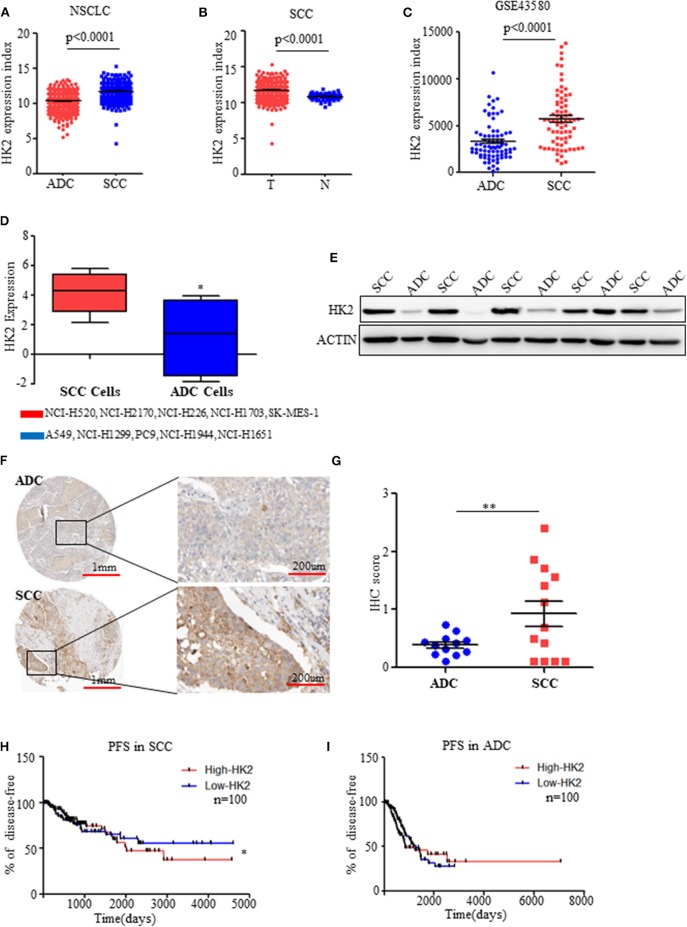
HK2 is highly expressed in SCC compared to ADC. (A) HK2 expression index in NSCLC samples from TCGA database. (B) HK2 expression index in SCC tumor samples compared with that in normal tissues from TCGA database. (C) HK2 expression index in NSCLC from the GSE43580 cohort. (D) HK2 expression in SCC cell lines (NCI-H520, NCI-H2170, NCI-H226, NCI-H1703, SK-MES-1) and ADC cell lines (A549, NCI-H1299, PC9, NCI-H1944, NCI-H1651). (E) Western blot showing the expression of HK2 in lung SCC (n = 6) and ADC (n = 6) samples. (F) Representative image of immunohistochemical (IHC) staining for HK2 expression in SCC (n = 12) and ADC (n = 11) patients. (G) IHC scores to quantify the expression of HK2 in ADC and SCC samples. (H) Percentage of PFS in SCC patients according to HK2 expression (High-HK2 n = 100, Low-HK2 n = 100) in TCGA database. (I) Percentage of PFS in ADC patients according to HK2 expression (High-HK2 n = 100, Low-HK2 n = 100) in TCGA database. *p < 0.05, **p < 0.01.